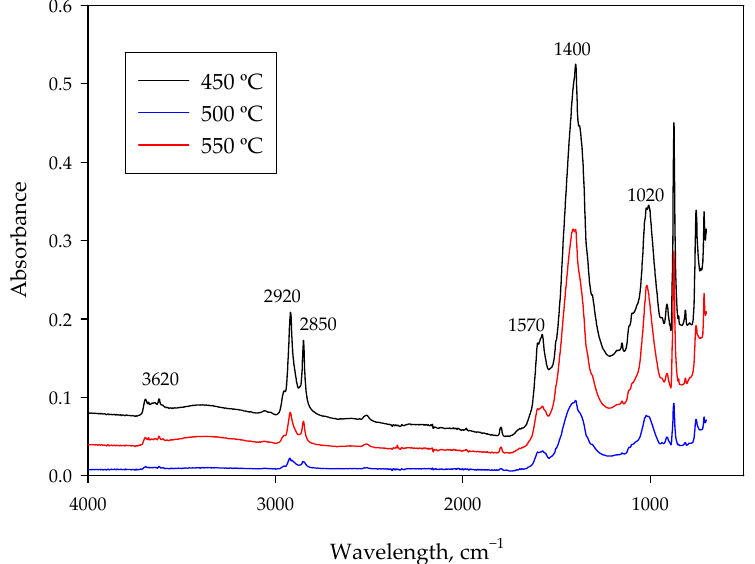
Figure 2. Infrared spectra of the solid pyrolysis products.